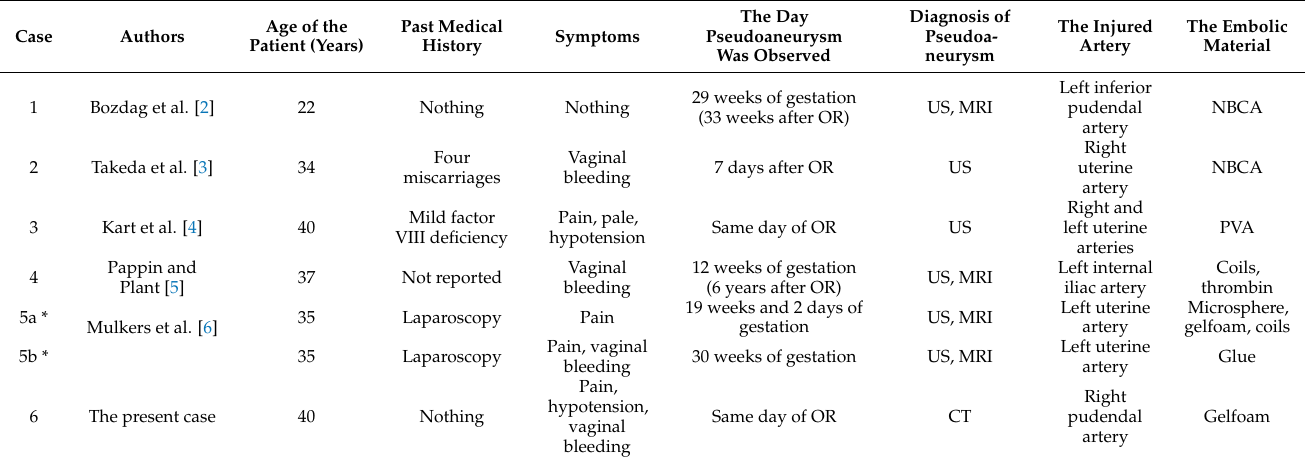
Table 1. TAE cases after transvaginal US-directed follicle aspiration for oocyte retrieval due to the presence of pseudoaneurysm.